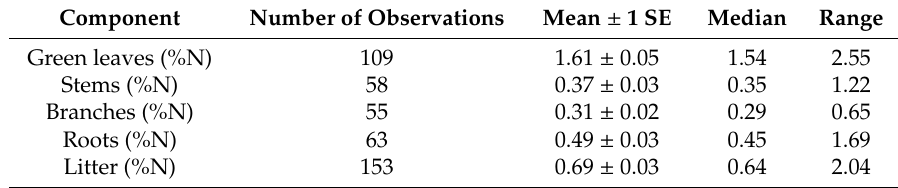
Table 1. Mean ( ± 1 standard error, SE) and median total nitrogen (TN) concentrations (as percentage of dry weight, DW) of various above- and belowground mangrove components, including soils to a depth of 1 m. The mean C / N ratios ( g / g ) are as follows: soil C / N = 11.3; live wood C / N = 130.4; belowground root C / N = 80.9; litter C / N = 79.4. The C / N values for biomass were calculated based on relative percentage of biomass DW in the respective components (i.e., stems + branches for wood estimate) and dead and live root and rhizome DW for belowground estimates using the carbon data and references in [39]. N data from [4,9–11,39–112] and earlier references within. Component Number of Observations Mean ± 1 SE Median Range Green leaves (%N) 109 1.61 ± 0.05 1.54 Stems (%N) 58 0.37 ± 0.03 Branches (%N) 55 0.31 ± 0.02 Roots (%N) 63 0.49 ± 0.03 Litter (%N) 153 0.69 ± 0.03